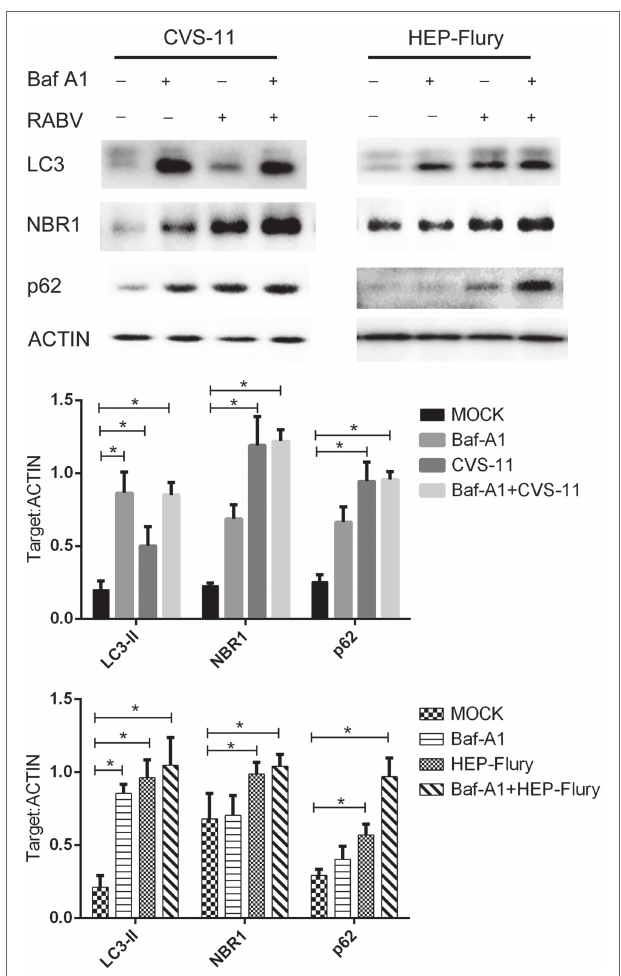
FIGURE 3 | Western blotting was used to analyze the expression level of p62, NBR1, and LC3. BV2 cells were incubated with 100 nM Bafilomycin A1 for 2 h and then were infected with CVS-11 or HEP-Flury at an MOI of 3. Cell lysates were harvested at indicated time points and Western blotting was performed using anti-p62, anti-NBR1, and anti-LC3 antibodies. The results present the relative expression levels of p62, NBR1, LC3-II, and β -actin visualized using the ImageJ software. Data are shown as mean ± SD, n = 3. Asterisks indicate significant differences between the groups calculated using a Student’s t -test (* p <